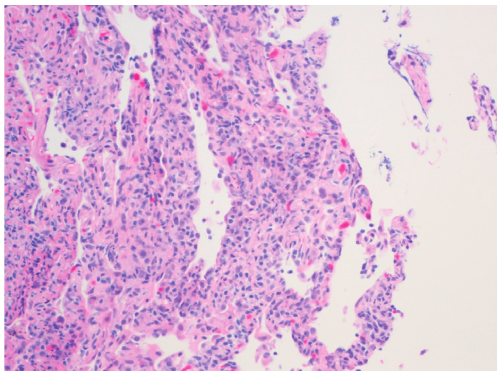
Figure 2: Pathological findings of lymphocytic interstitial pneu- monitis. High-power analysis of lung tissue shows interstitial septa thickening, infiltration by small- to medium-sized lymphocytes (hematoxylin-eosin, magnification ×